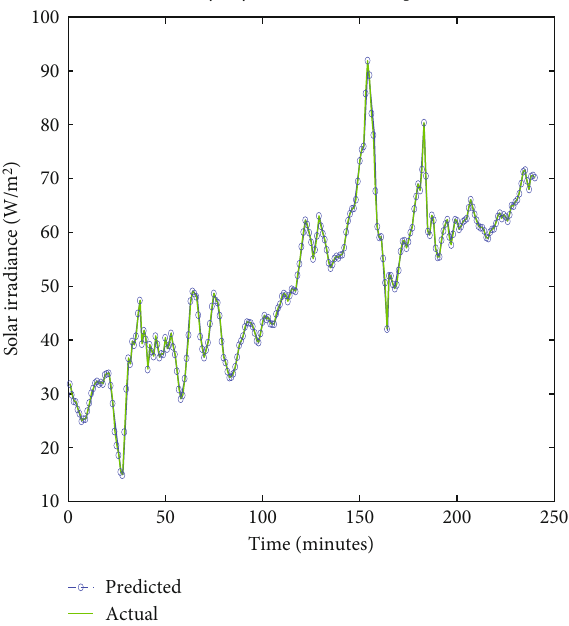
Figure 31: Comparison of predicted solar irradiance and actual solar irradiance for cloudy day four-hour-ahead prediction.